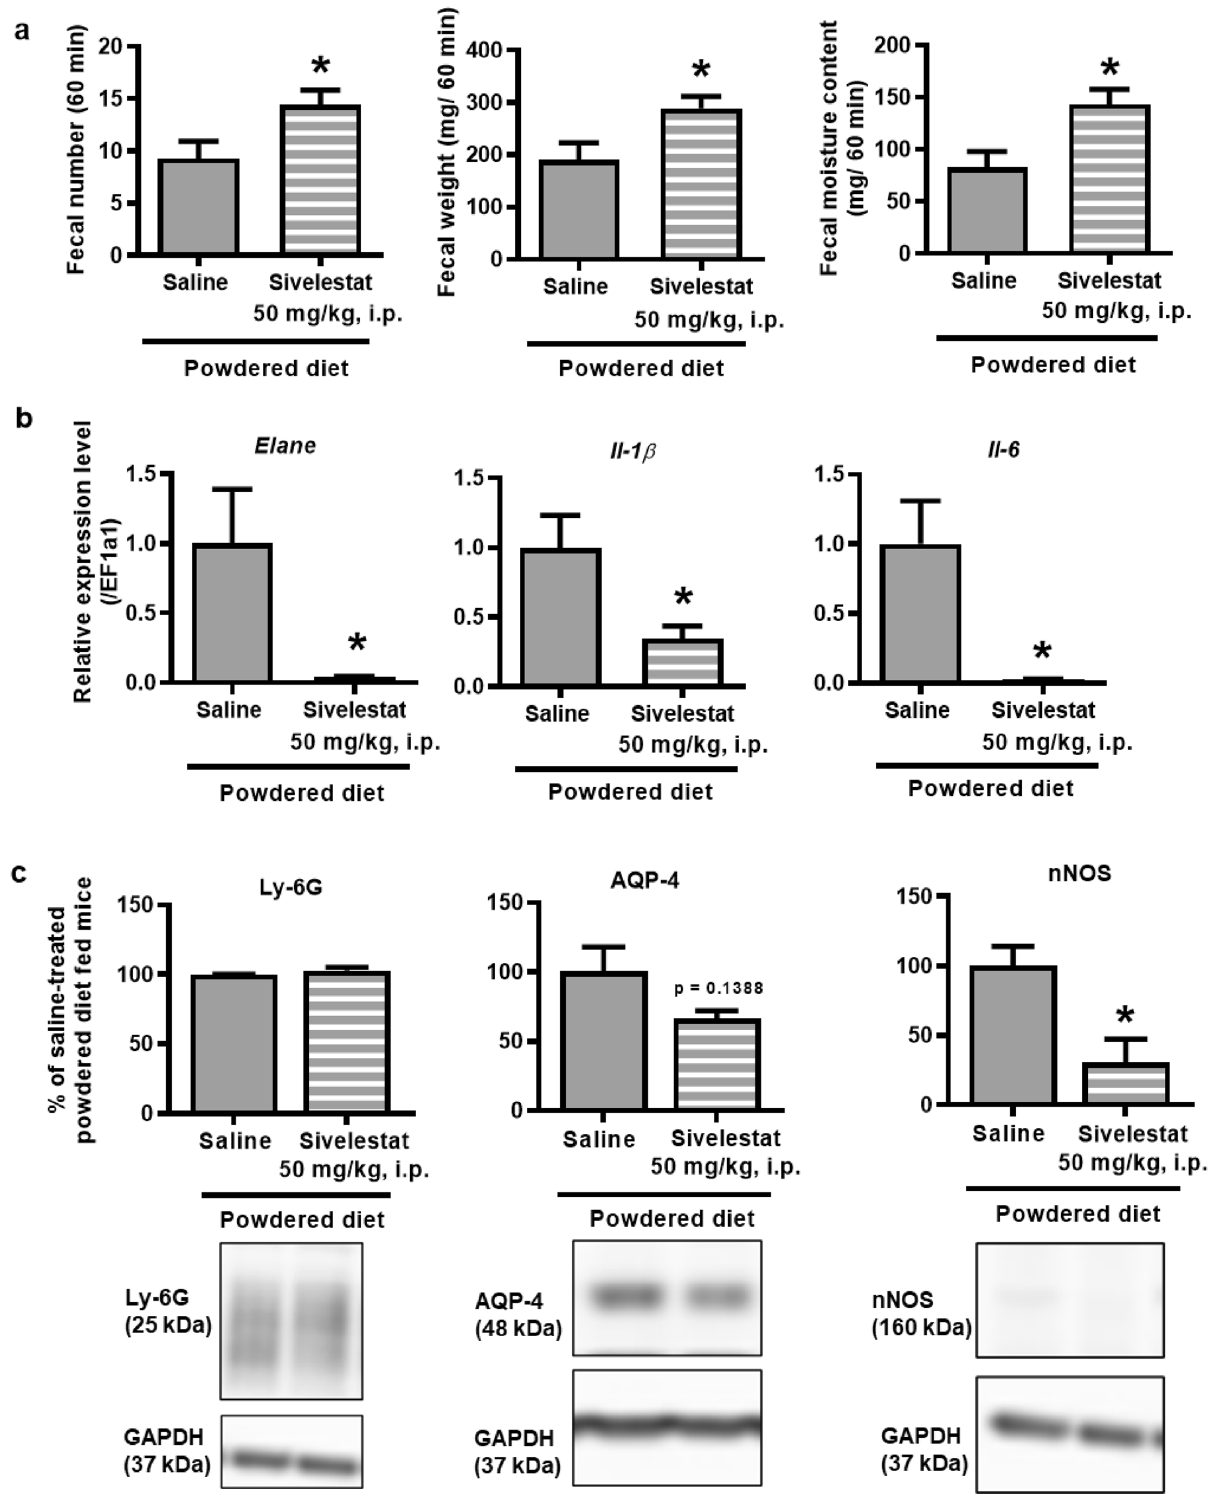
Figure 6. Effect of sivelestat (50 mg/kg, i.p.), a neutrophil elastase inhibitor, on the constipation-like symptoms of long-term powdered diet-fed mice. ( a ) Fecal pellet count, total fecal weight, and fecal moisture content (p = 0.0344, 0.0314, and 0.0140, respectively, n = 7 per group), ( b ) PCR analysis of Elane , IL-1β and IL-6 in the colons of mice (p = 0.0388, 0.0300, and 0.0136, respectively, n = 5 per group), and ( c ) western blotting analysis of Ly-6G, aquaporin-4 (AQP-4), and neural nitric oxide synthase (nNOS) in the colons of the mice (p = 0.3055, 0.1388, and 0.0399, respectively, n = 3 per group). Full length blots are presented in Supplementary Fig. S6. The data are given as the mean ± SEM for a group. Student’s t -test was used to determine statistical significance. *p < 0.05; vs. vehicle-treated powdered diet-fed mice